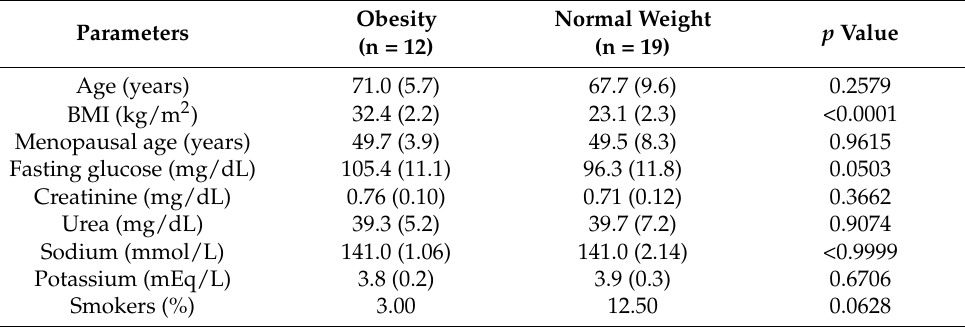
Table 1. Demographic and clinical features of the study subjects.